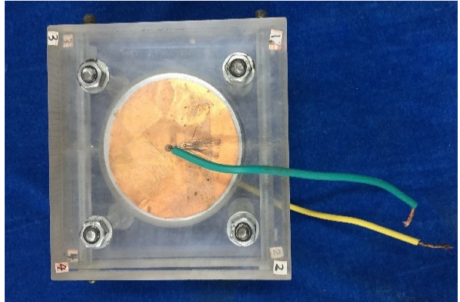
Figure 2. Electrochemical impedance spectroscopy measuring